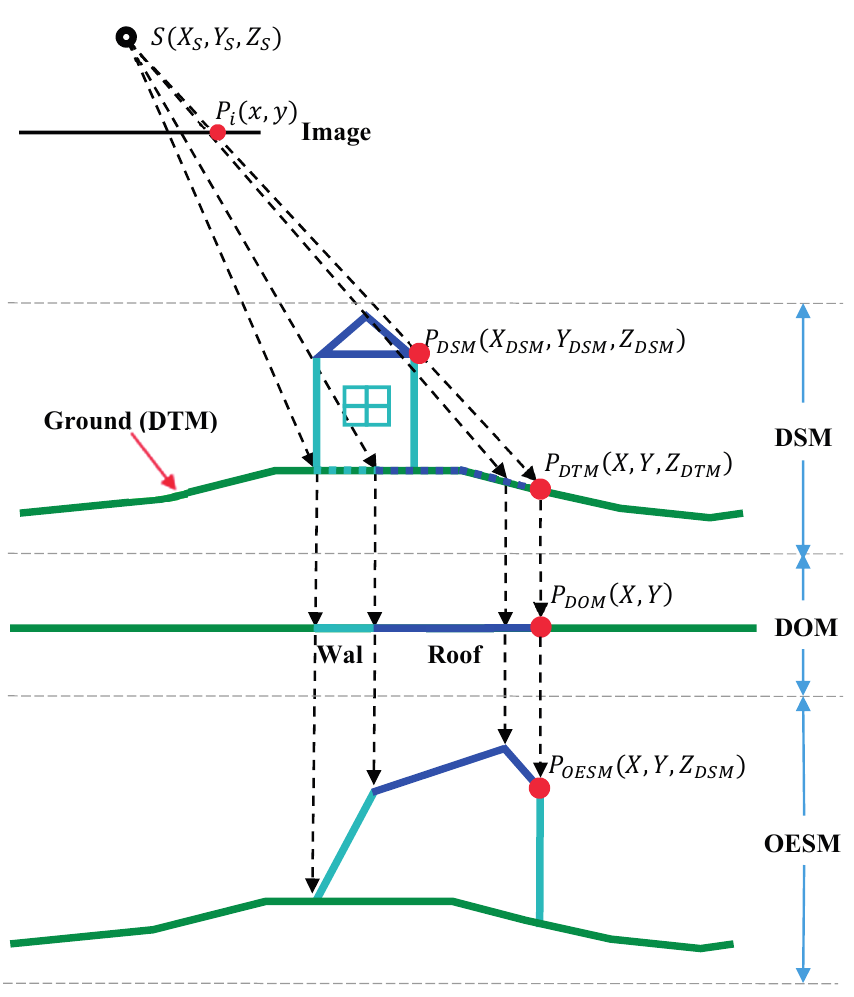
Figure 2. Geometric relationship of DSM, DTM, DOM, and the proposed OESM. (cid:1845) is the , (cid:1842) , (cid:1842) and (cid:1842) are the corresponding points of the original perspective center; (cid:1842) (cid:3036) (cid:3005)(cid:3020)(cid:3014) (cid:3005)(cid:3021)(cid:3014) (cid:3005)(cid:3016)(cid:3014) image, DSM, DTM and DOM, respectively; and (cid:1842) is the corresponding point of the (cid:3016)(cid:3006)(cid:3020)(cid:3014) proposed orthoimage elevation synchronous model